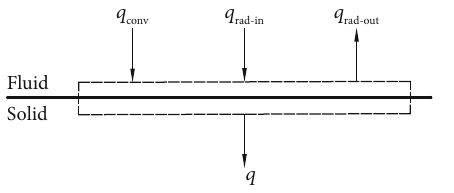
Figure 1: Energy conservation at the coupling interface.